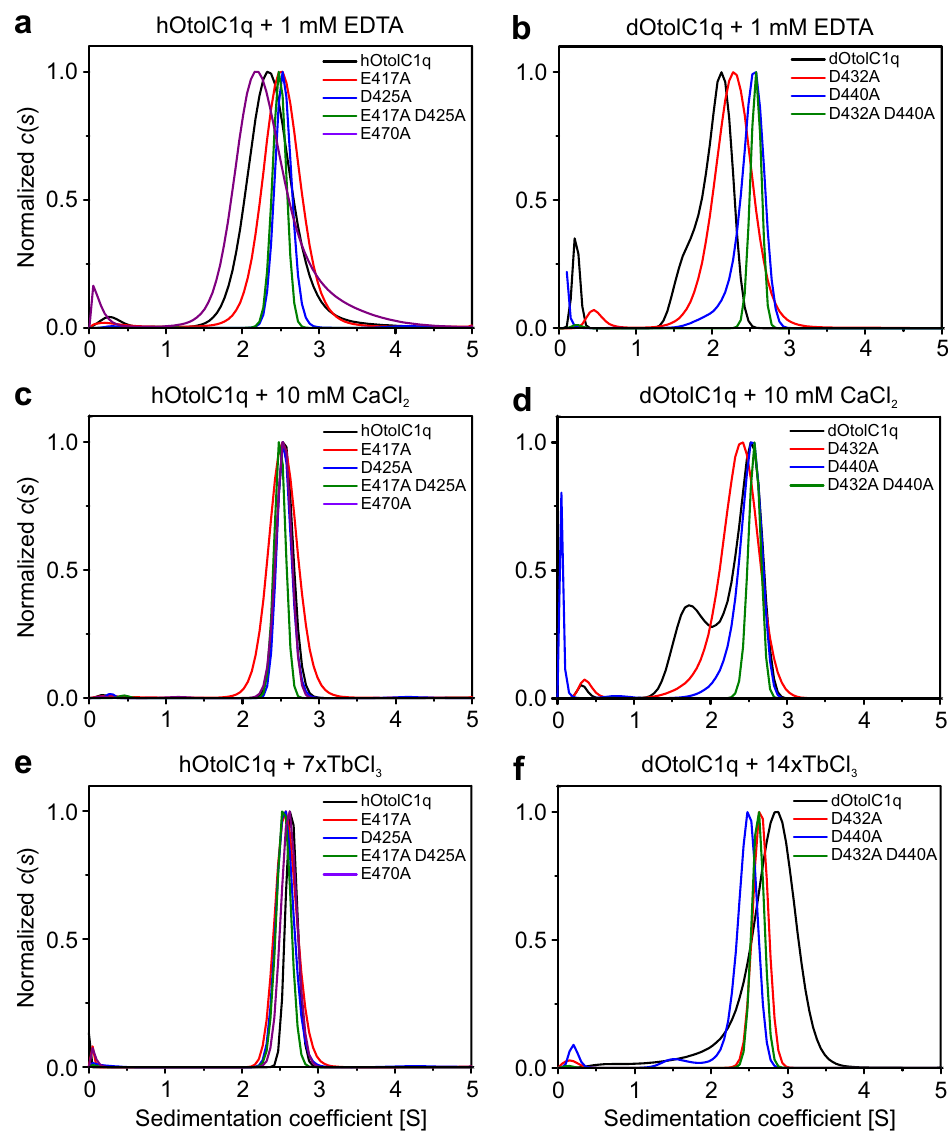
Figure 4. Normalized sedimentation coefficient distributions ( c ( s )) of hOtolC1q, dOtolC1q and their mutants in the presence of Ca 2+ and Tb 3+ . The results of sedimentation velocity analytical ultracentrifugation (SV AUC) experiments for ( a , c , e ) hOtolC1q, ( b , d , f ) dOtolC1q and their mutants in the presence of ( a , b ) 1 mM EDTA, ( c , d ) 10 mM CaCl 2 , ( e ) sevenfold molar excess of TbCl 3 or ( f ) 14-fold molar excess of TbCl 3 . The protein concentration was in the range of 0.20–0.25 mg/mL. SV AUC data were fitted to a continuous sedimentation coefficient distribution ( c ( s )) model using SEDFIT software. The plots were standardized for a maximal c ( s ) peak in the range 0.5–4.5 S. See also Suppl. Fig. 2, Suppl. Fig. 3 and Suppl. Table